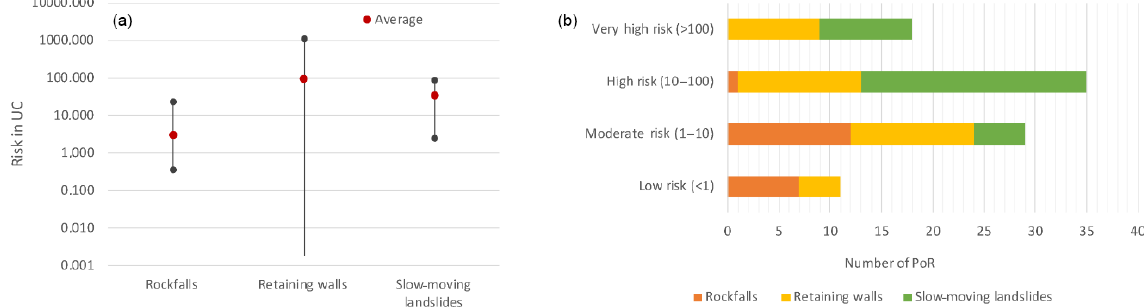
Figure 10. (a) Average, maximum, and minimum calculated risk for each hazard type; (b) number of PoR per hazard type in each risk class.